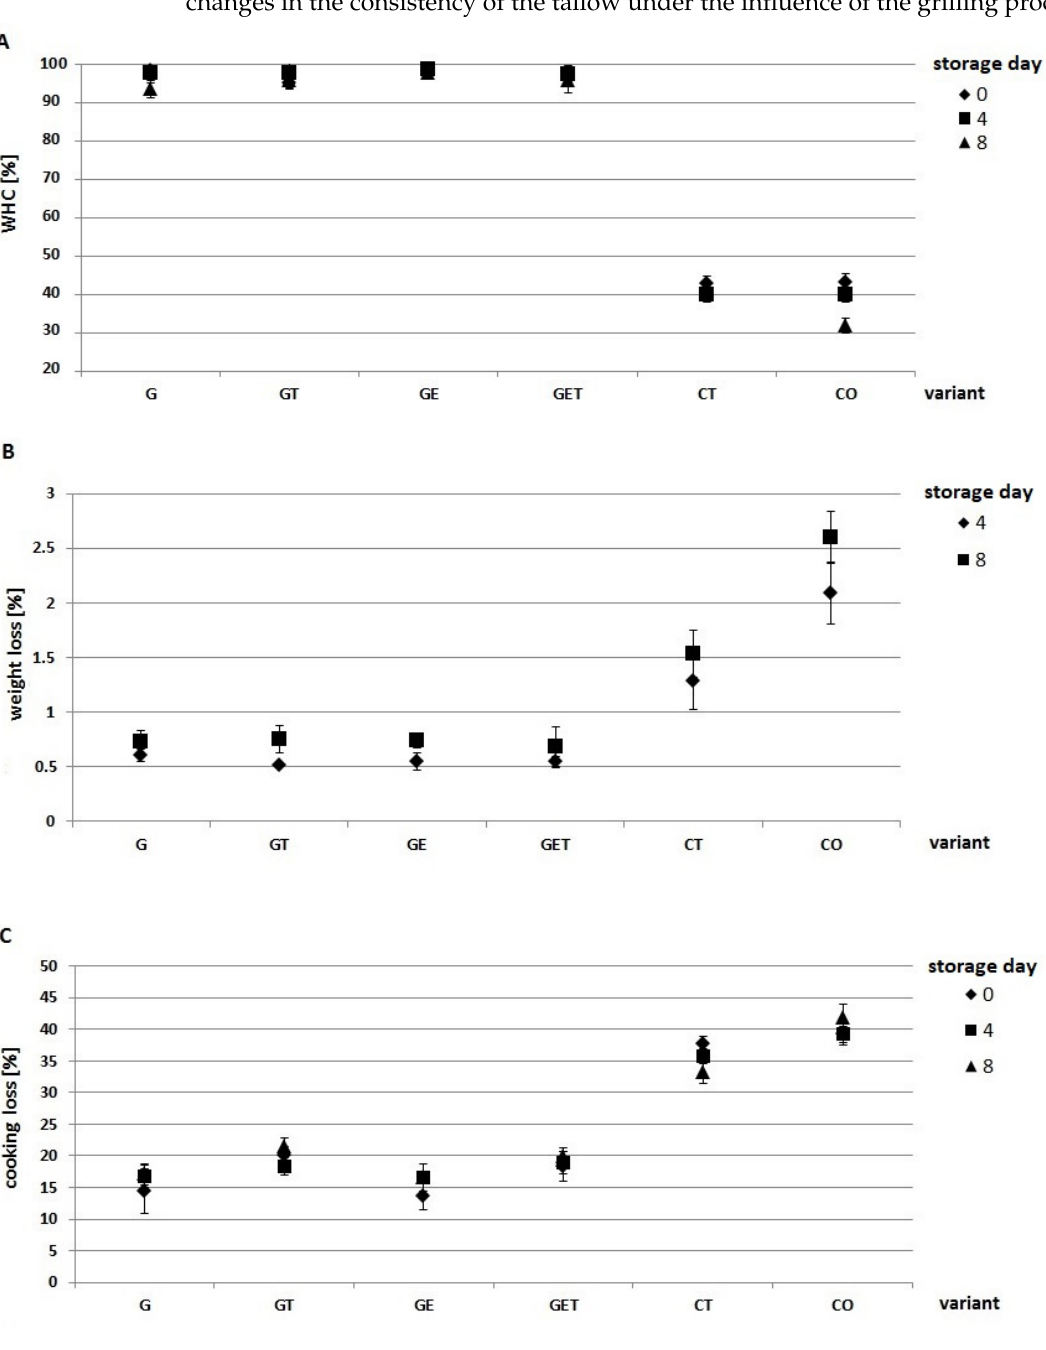
Figure 4. Effect of a fat substitute on water retention (WHC) ( A ); weight loss ( B ); and cooking loss ( C ), after 0, 4, and 8 days of storage. G—encapsulated oil; GT—encapsulated oil + tallow; GE—encapsulated oil with açai extract; GET—encapsulated oil with açai extract + tallow; CT—control with tallow; CO—control with oil.